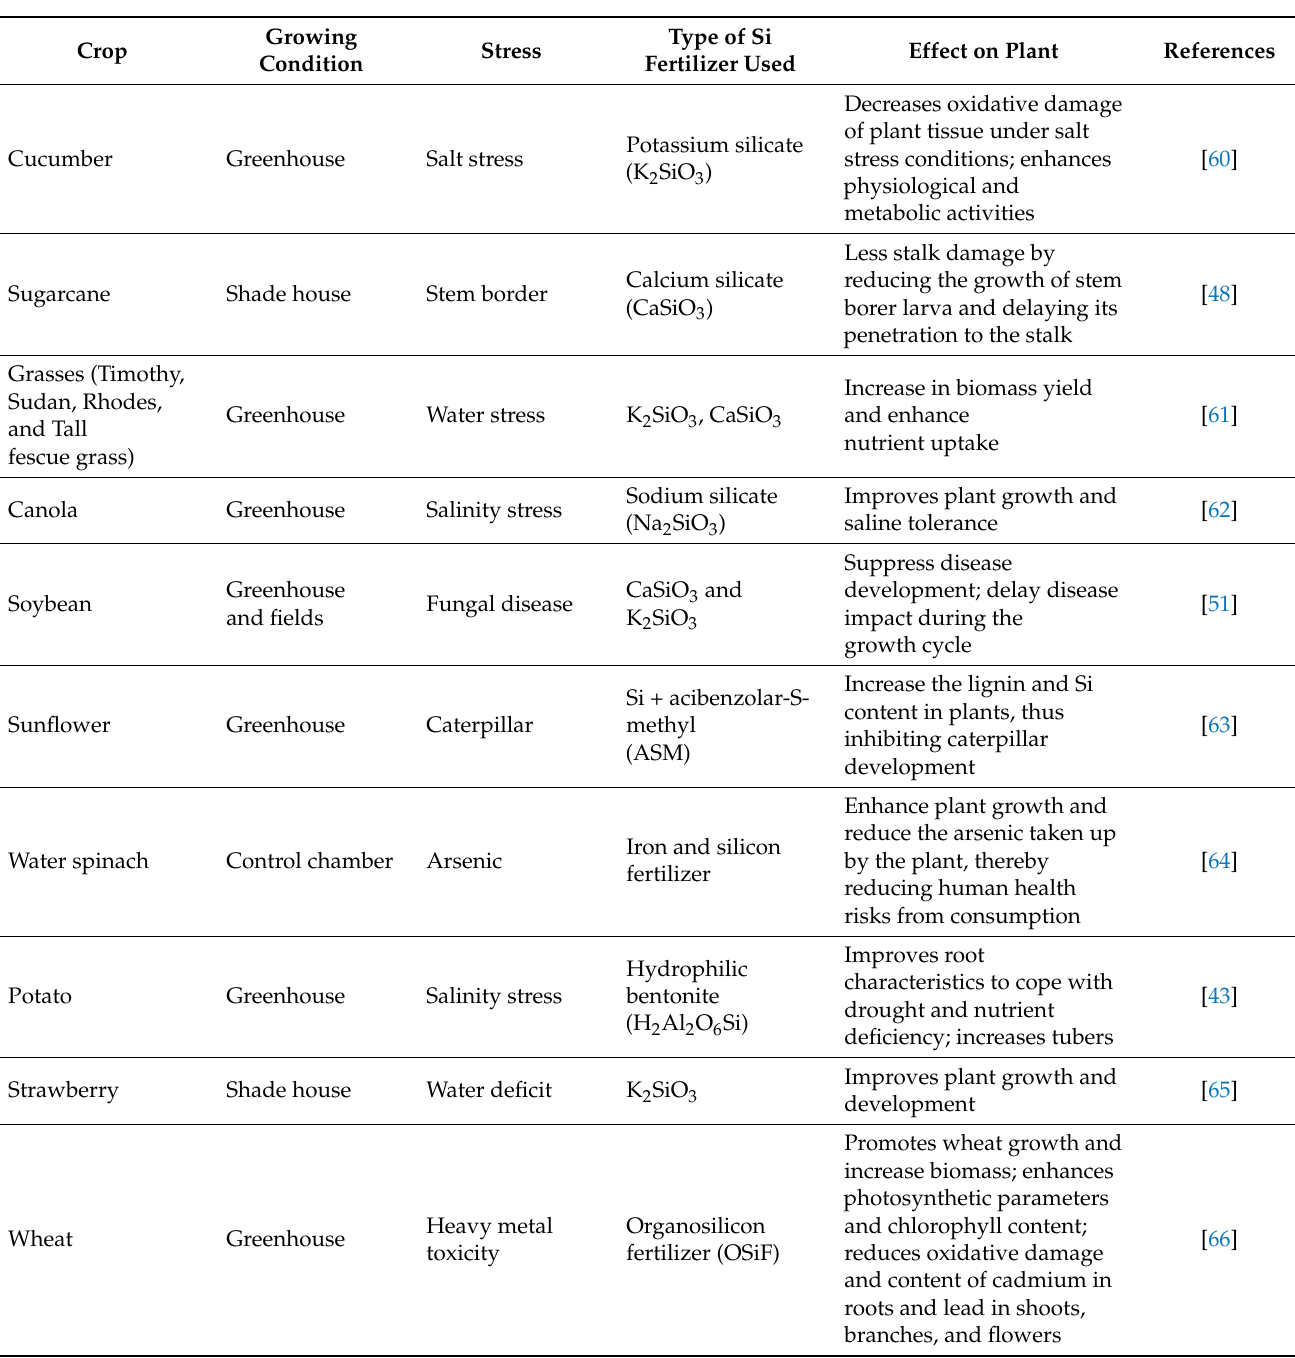
Table 1. Effects of silicon fertilizers on monocotyledon and dicotyledon